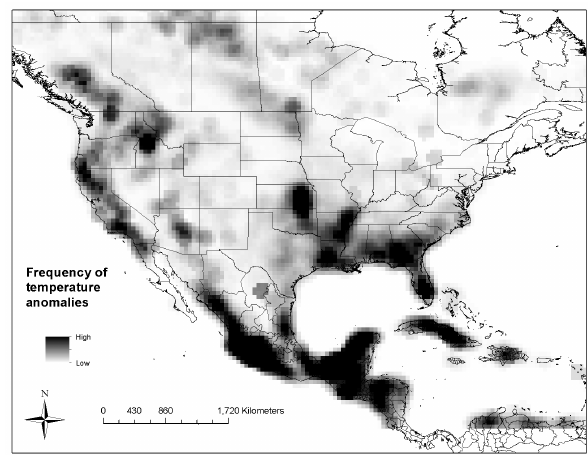
Figure 8. Cumulative Terra and Aqua MODIS fire and thermal anomalies generated from 2 Fig. 8. Cumulative Terra and Aqua MODIS fire and thermal anoma- MODIS data for the monitoring period. The size of the grid cells is 0.5 o per side. 3 lies generated from MODIS data for the monitoring period. The size of the grid cells is 0.5 ◦ per